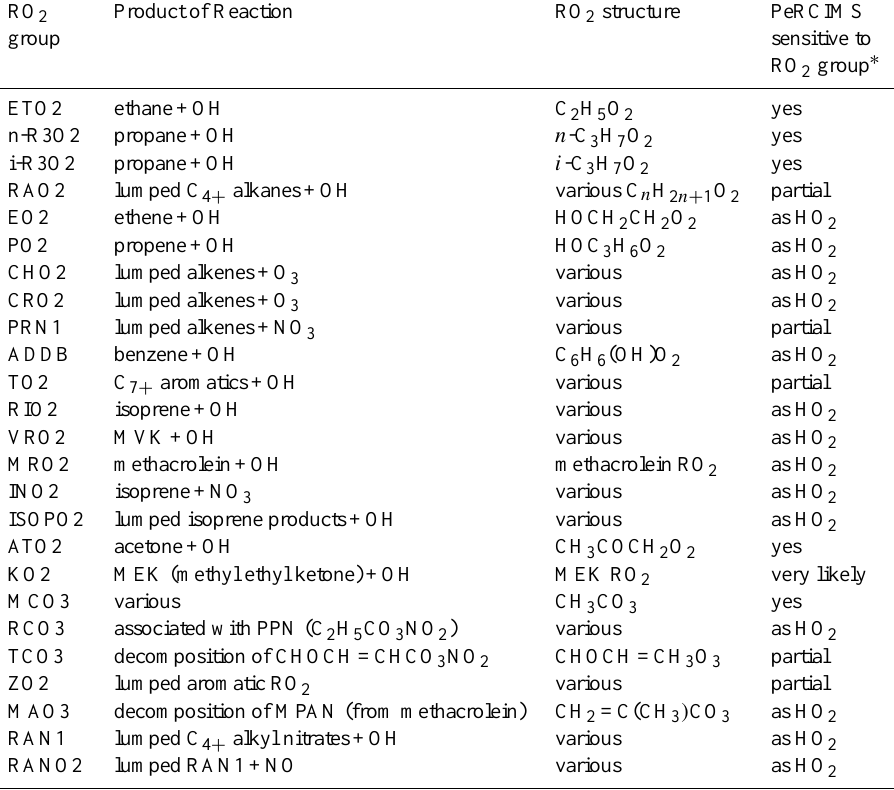
Table 6. Parameterized box model RO 2 groups comprising the non-CH 3 O 2 RO 2